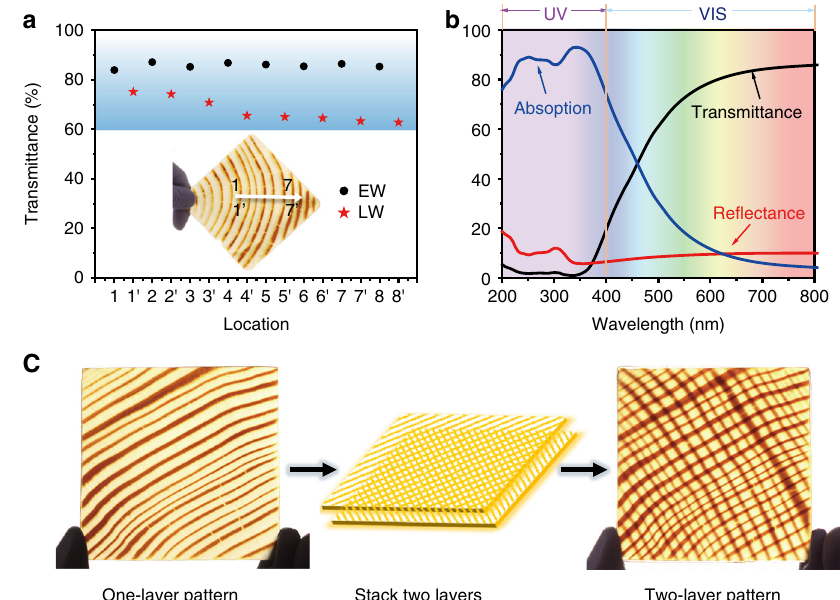
Fig. 4 Optical properties and patterns design of aesthetic wood. a The transmittance in the EW and LW of obtained aesthetic wood (The locations marked 1 – 8 represent the EW areas while 1 ′ – 8 ′ represent the LW areas). b As-prepared aesthetic wood exhibits excellent UV-blocking performance: high absorption in 200 – 400 nm, high transmittance at 600 nm and low re fl ectance. c The latticed aesthetic patterns can be obtained by stacking two layers of aesthetic